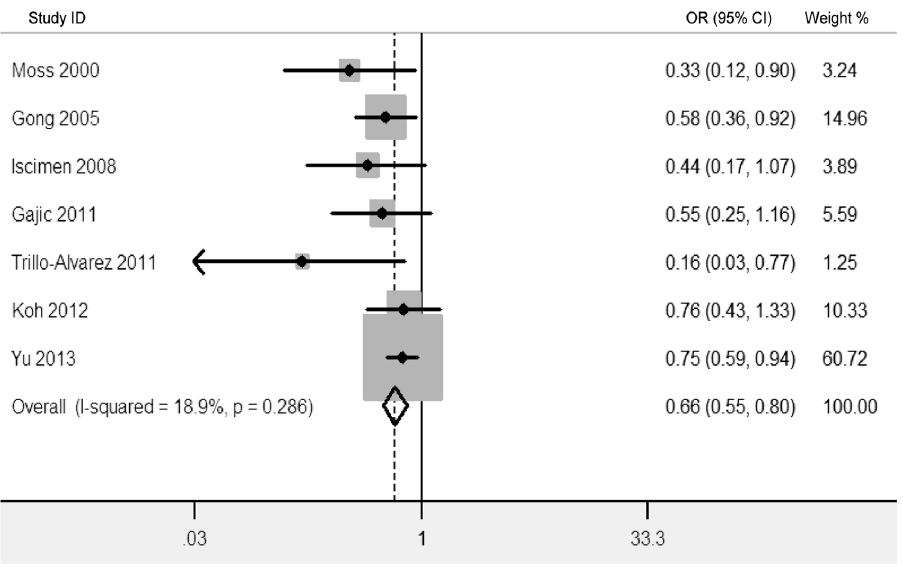
Figure 2. Forest plot showing the risk of ALI/ARDS in critically ill adult patients with pre-existing diabetes.